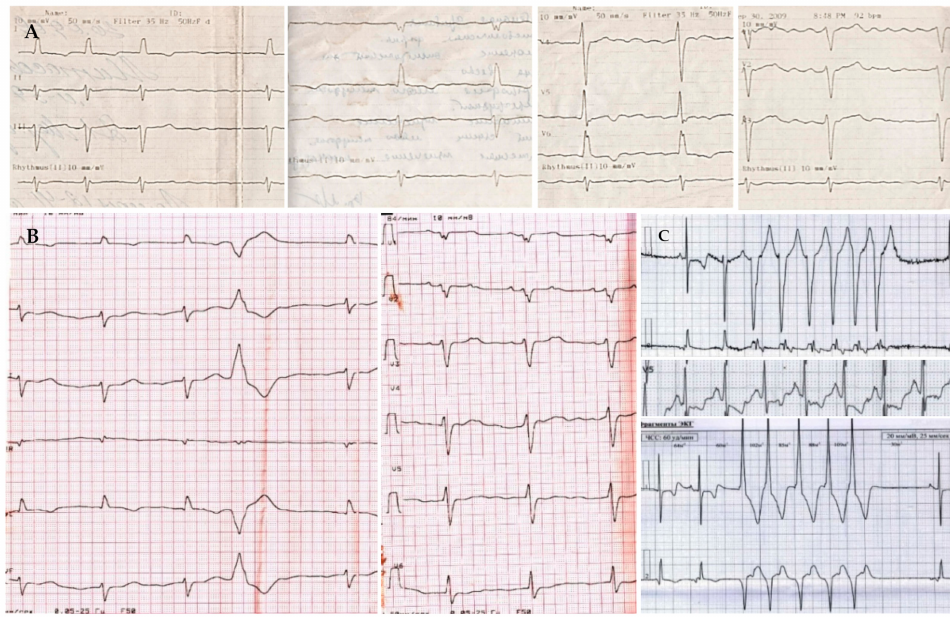
Figure 1. Electrocardiograms of proband. ( A ) (upper line)—ECG registered in 2009 (atrial fibrillation); ( B ) (left in the lower line)—ECG at the admission to the clinic in June 2014 (sinus bradycardia with a left axis, low QRS voltage, premature ventricular beats); ( C ) (right in the lower line)—24-h ECG monitoring registered in June 2014 (nonsustained ventricular tachycardia, 5 beats). Paper speed is 25